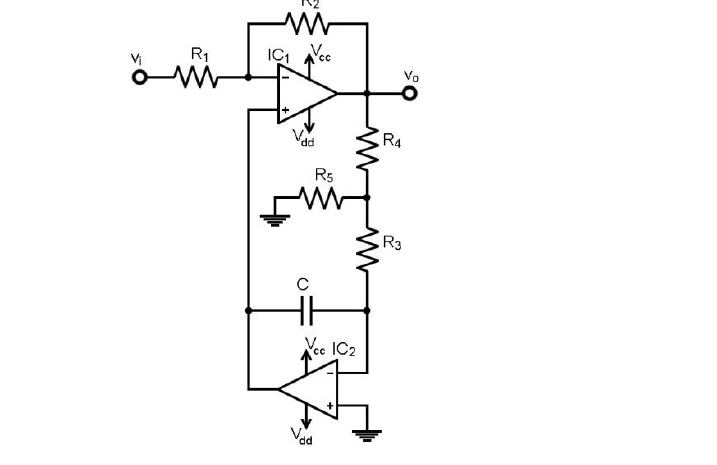
Figure 4. Proposed design for the high-pass filter with gain using an inverter op-amp stage in the